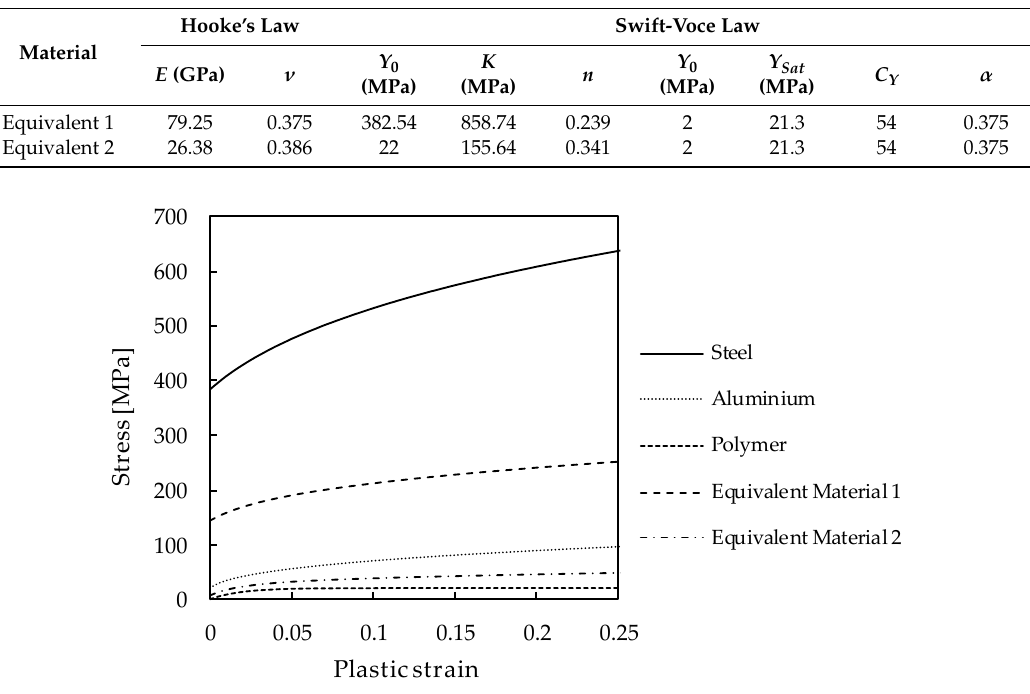
Figure 4. Hardening curves of the metallic and polymer layers of the composites and of the equivalent materials.